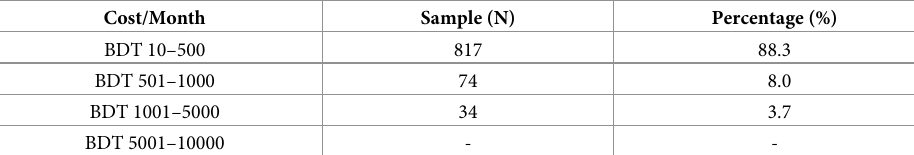
Table 5. Cost of dietary supplements per month in Taka.